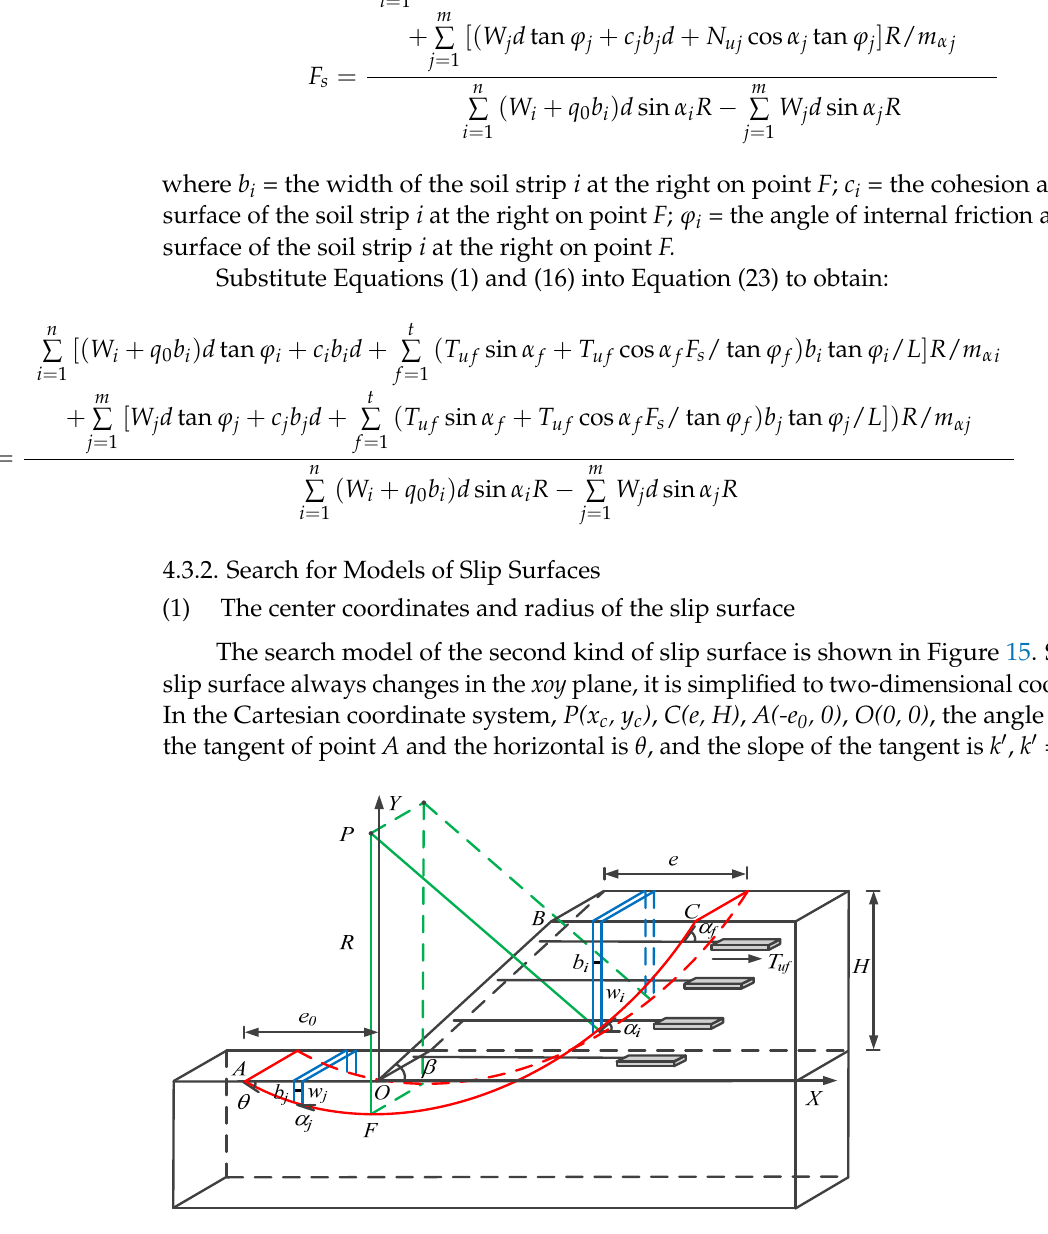
Figure 15. Search model of the second kind of slip surface.